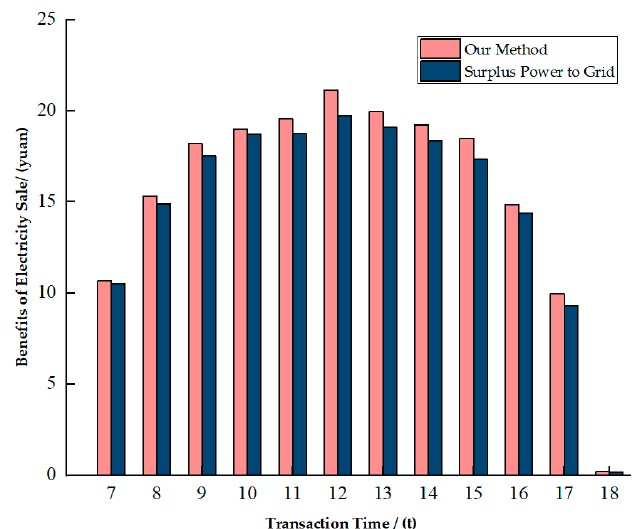
Energies 2018 , 11 , x FOR PEER REVIEW Figure 4. Costs of electricity purchase. Figure 4. Costs of electricity purchase.